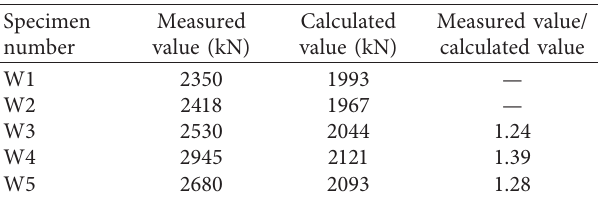
Table 4: Calculation of bearing capacity of composite shear wall under axial